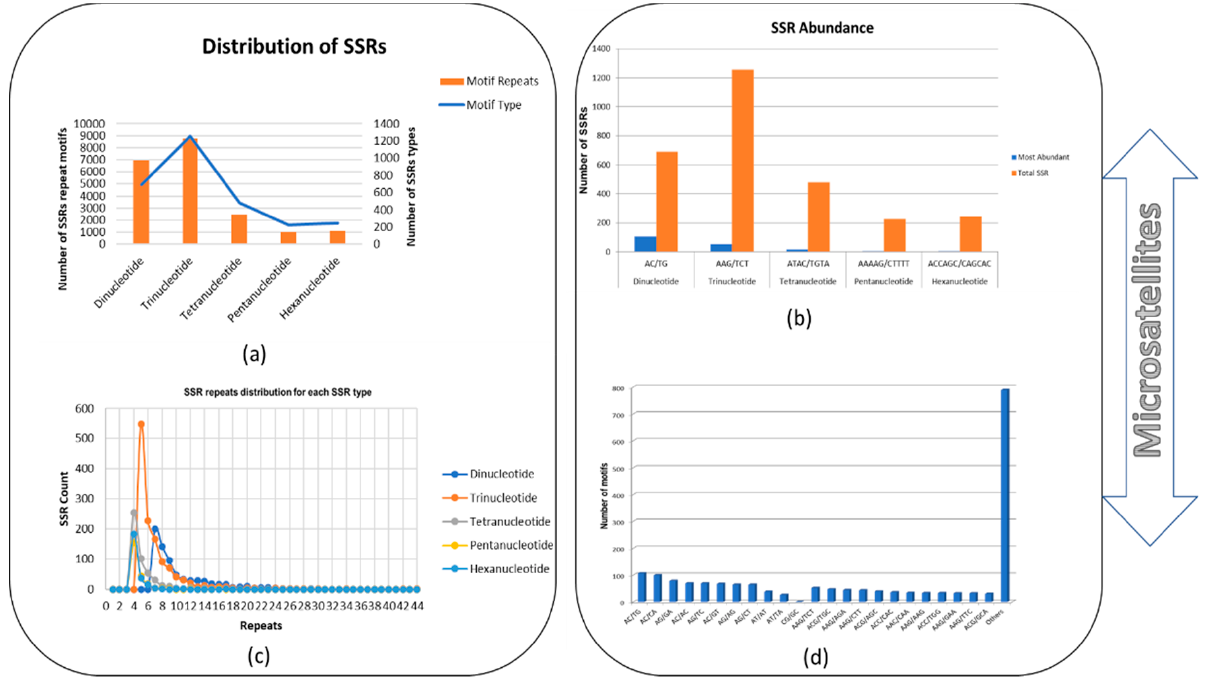
Figure 2. Showing distribution of SSRs in B. sorokiniana genome: ( a ) number of SSR repeat motifs; ( b ) SSR abundance; ( c ) SSR repeat distribution; ( d ) frequency of dinucleotide and trinucleotide SSR repeat motifs in the genome.